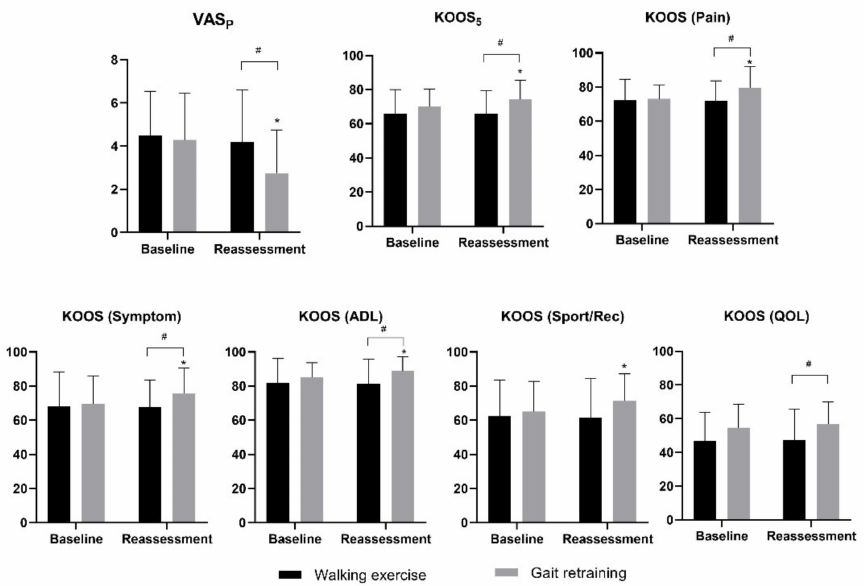
Figure 5. Effects of gait retraining on clinical outcomes (VASP, KOOS 5 , subscales of KOOS scores). Error bars indicate standard deviations. * indicates significant within-group difference between post and pre-training score. # indicates significant between-group difference at certain time